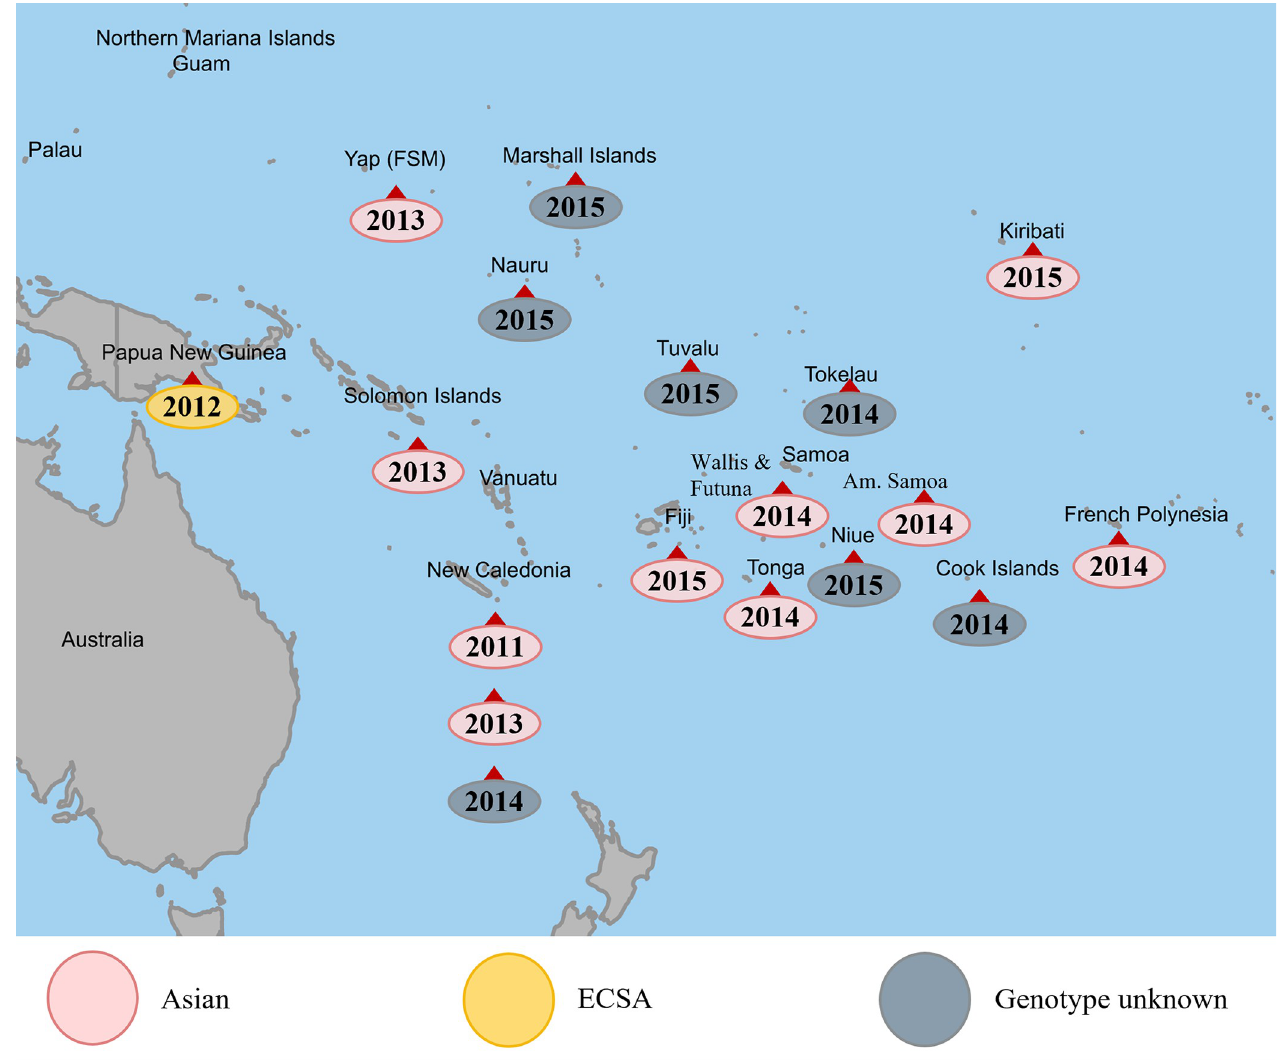
Fig 1. History of CHIKV outbreaks in the SPR, including genotype if known. Source: [10,13,17,18,19,20,21,22,23,24,25,26], base layer made with Natural Earth (naturalearthdata.com).